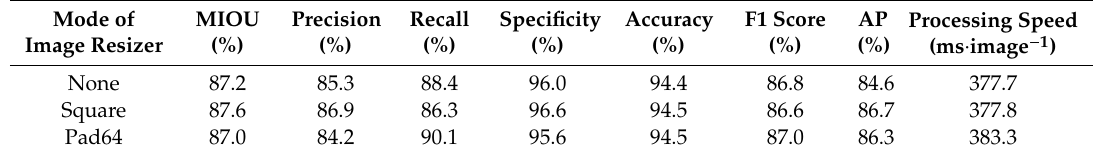
Table 5. Performance of various image resizers.